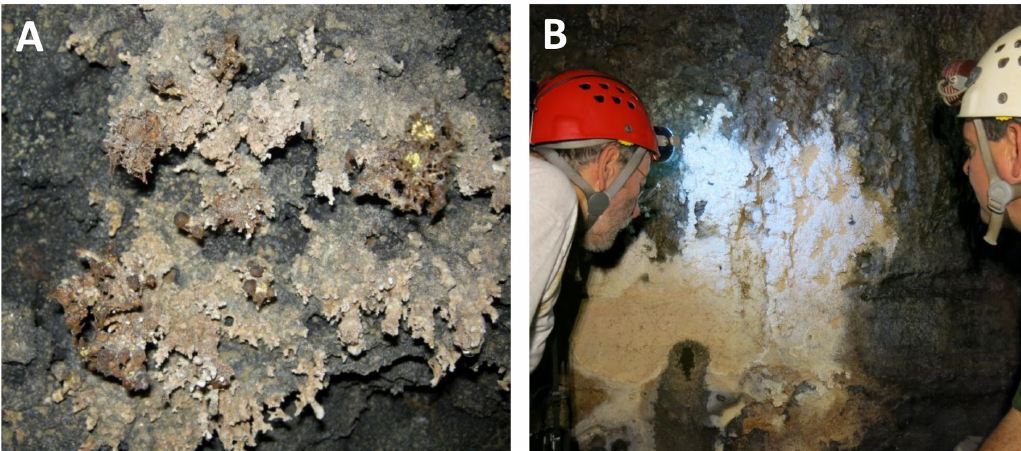
Figure 2. Field images of the speleothems collected in the lava tubes from Santa Cruz Island (Galapagos, Ecuador): ( A ) Coralloid stalactites with whitish coatings (Royal 2) from Royal Palm Cave; ( B ) white moonmilk coating the walls of Bellavista Cave.